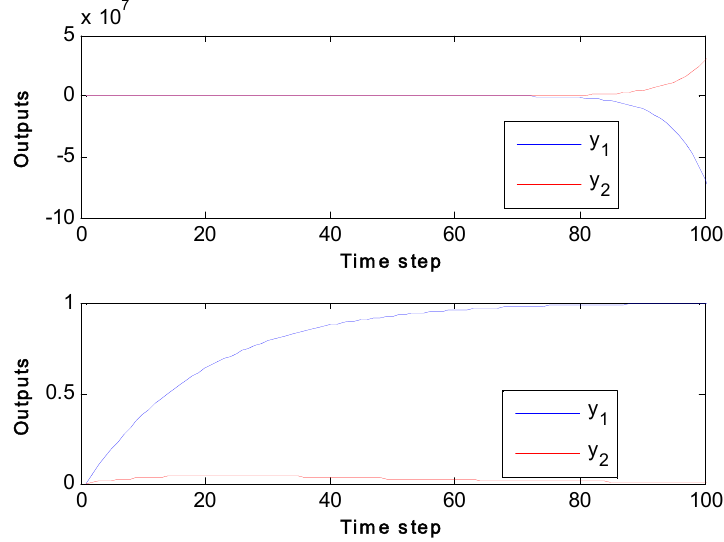
= 1) and 1 1 sp y  ) and no 1 ˆ P 2 1 (top) and